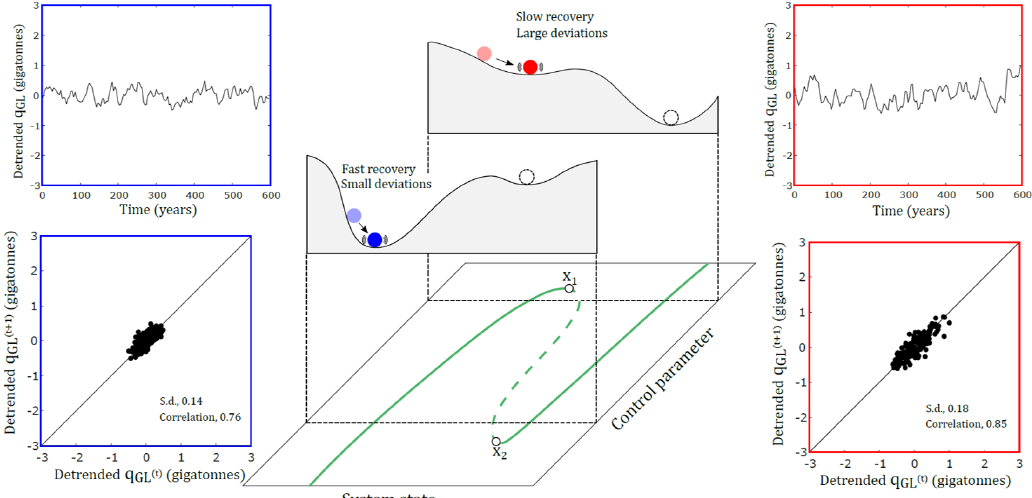
Figure 2. Critical slowing down can serve as an indicator that the system is approaching a tipping point. This can be understood conceptually using the common “ball on a slope” analogy (middle panel), where the ball represents the system state and minima are stable equilibrium states. Two example cases are superimposed onto their corresponding positions in the hysteresis plot of MISI shown by the green line and equivalent to Fig. 1c. The processed model results demonstrate how critical slowing down manifests itself, as shown in the blue and red panels at the sides. If the system is far from a tipping point (blue case), the system state (which is in this study the grounding-line flux q GL , upper left panel) recovers quickly from perturbations in the control parameter (which is here the basal melt variability). This means that from one measurement (at time t ) to the next (at time t + 1) the grounding-line flux changes rapidly and has a low lag-1 auto-correlation (lower left panel). Conversely, close to a tipping point (red case), critical slowing down manifests and the system state responds more slowly to perturbations in the control parameter (upper right panel). Since the state variable is changing more slowly, successive measurements are more similar, resulting in a higher lag-1 auto-correlation (lower right